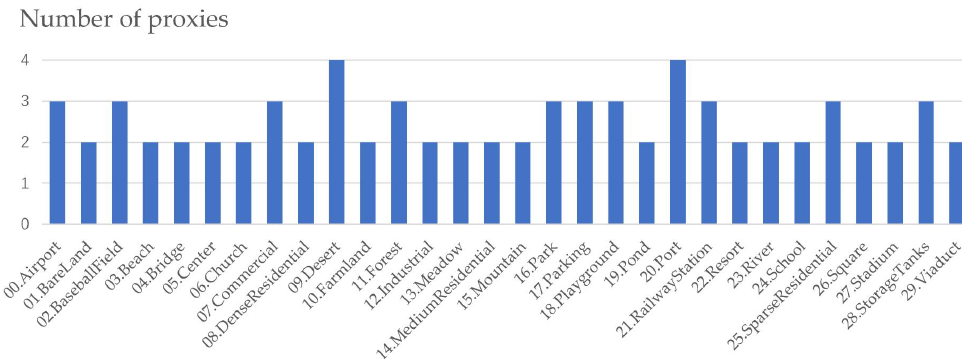
Figure 11. The number of proxies assigned to each class in the AID dataset by our proposed adaptive multi-proxy assignment method.